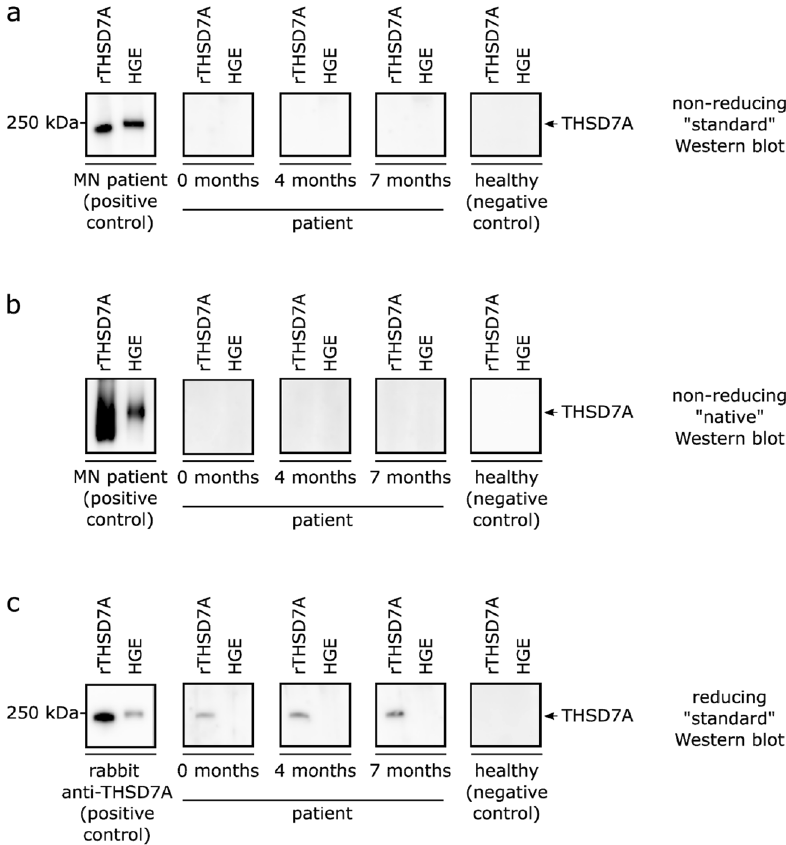
Figure 2. Results of Western blot analyses. In Western blot analyses serum of the patient was used as primary antibody. The Western blots, which were performed under ( a ) non-reducing, “standard” conditions (SDS present); and ( b ) non-reducing, “native” conditions (SDS absent) do not give any detectable THSD7A-specific signal. For the positive control in A and B, serum from a THSD7A-antibody positive MN patient was used. ( c ) Western blot analysis under reducing, “standard” conditions (SDS present) gave a Western blot signal at the expected height for rTHSD7A, but not for HGE. Also for lung tissue extract no signal was obtained (not shown). For the positive control, rabbit anti-human THSD7A was used. For all three analyses, serum from a healthy donor served as negative